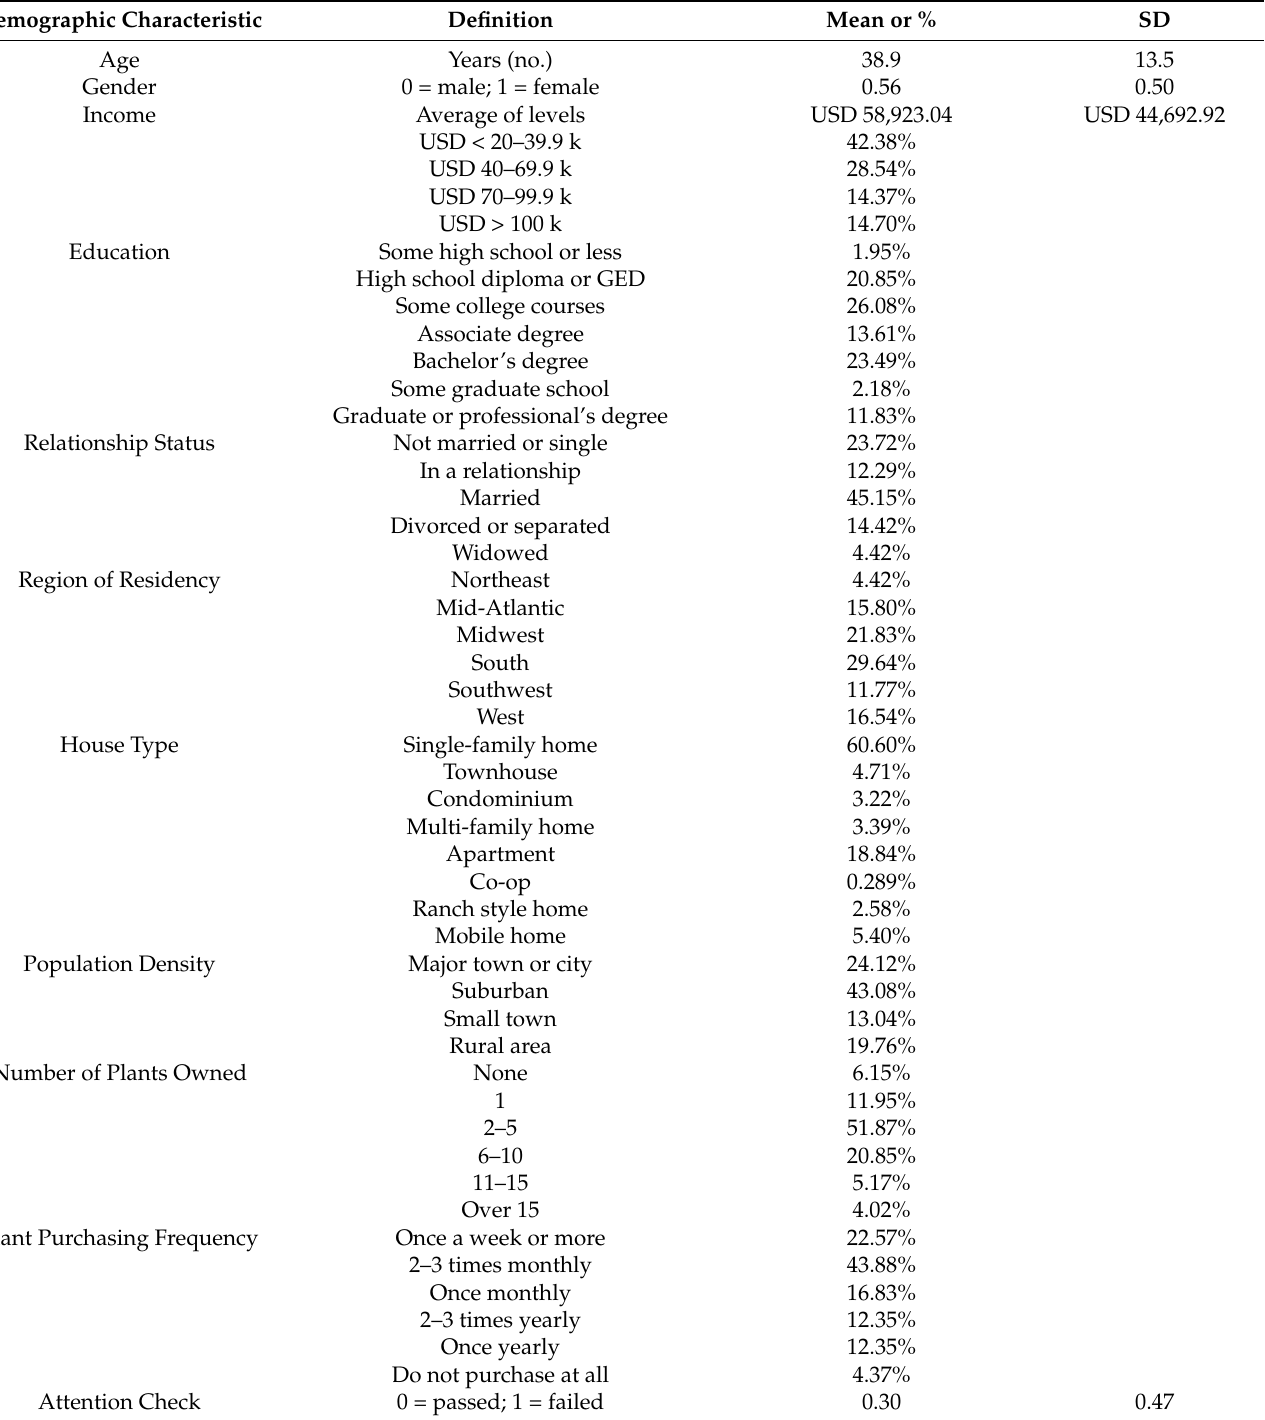
Table 2. Demographic characteristics (independent variables) of the